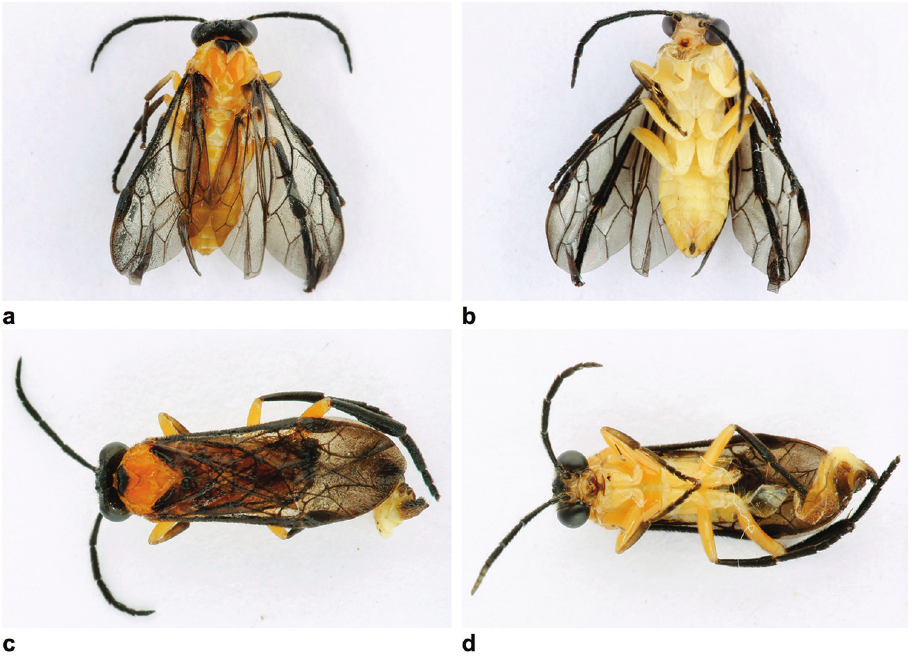
Figure 12. Waldheimia pallens . a, b Female (P4215.H), body length 8.0 mm c, d male (P4215.J), body length unknown. a, c Dorsal views b, d ventral views.